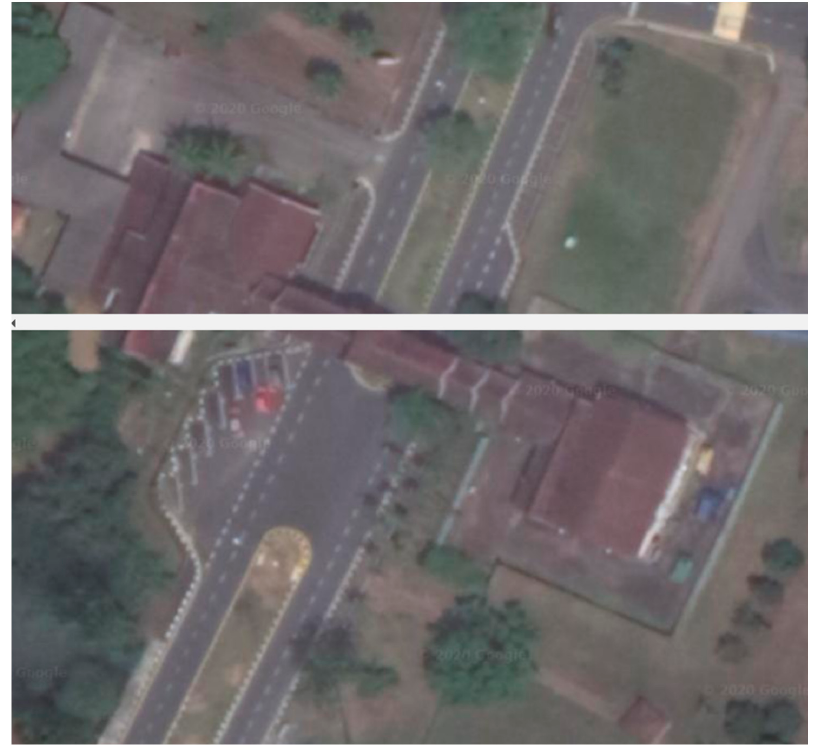
Figure 3. Example of aerial photo for building footprint.